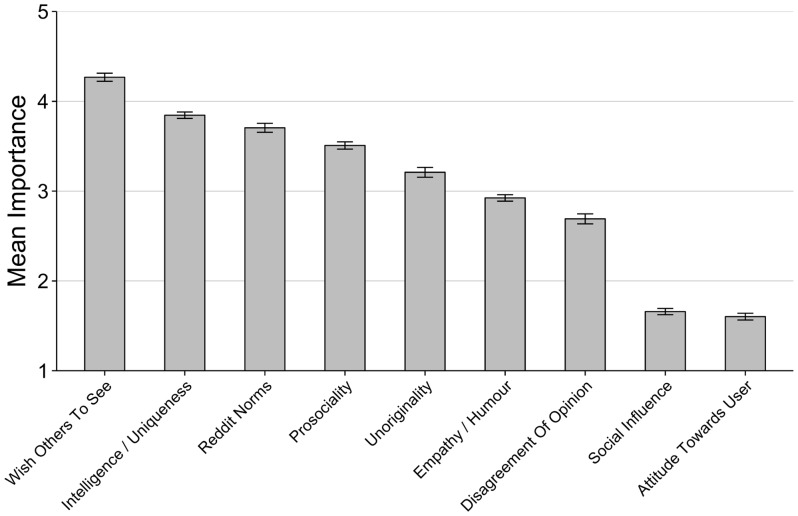
Mean importance of emergent influences on voting.Values are mean Likert responses on a scale of 1–5. Error bars indicate standard error.